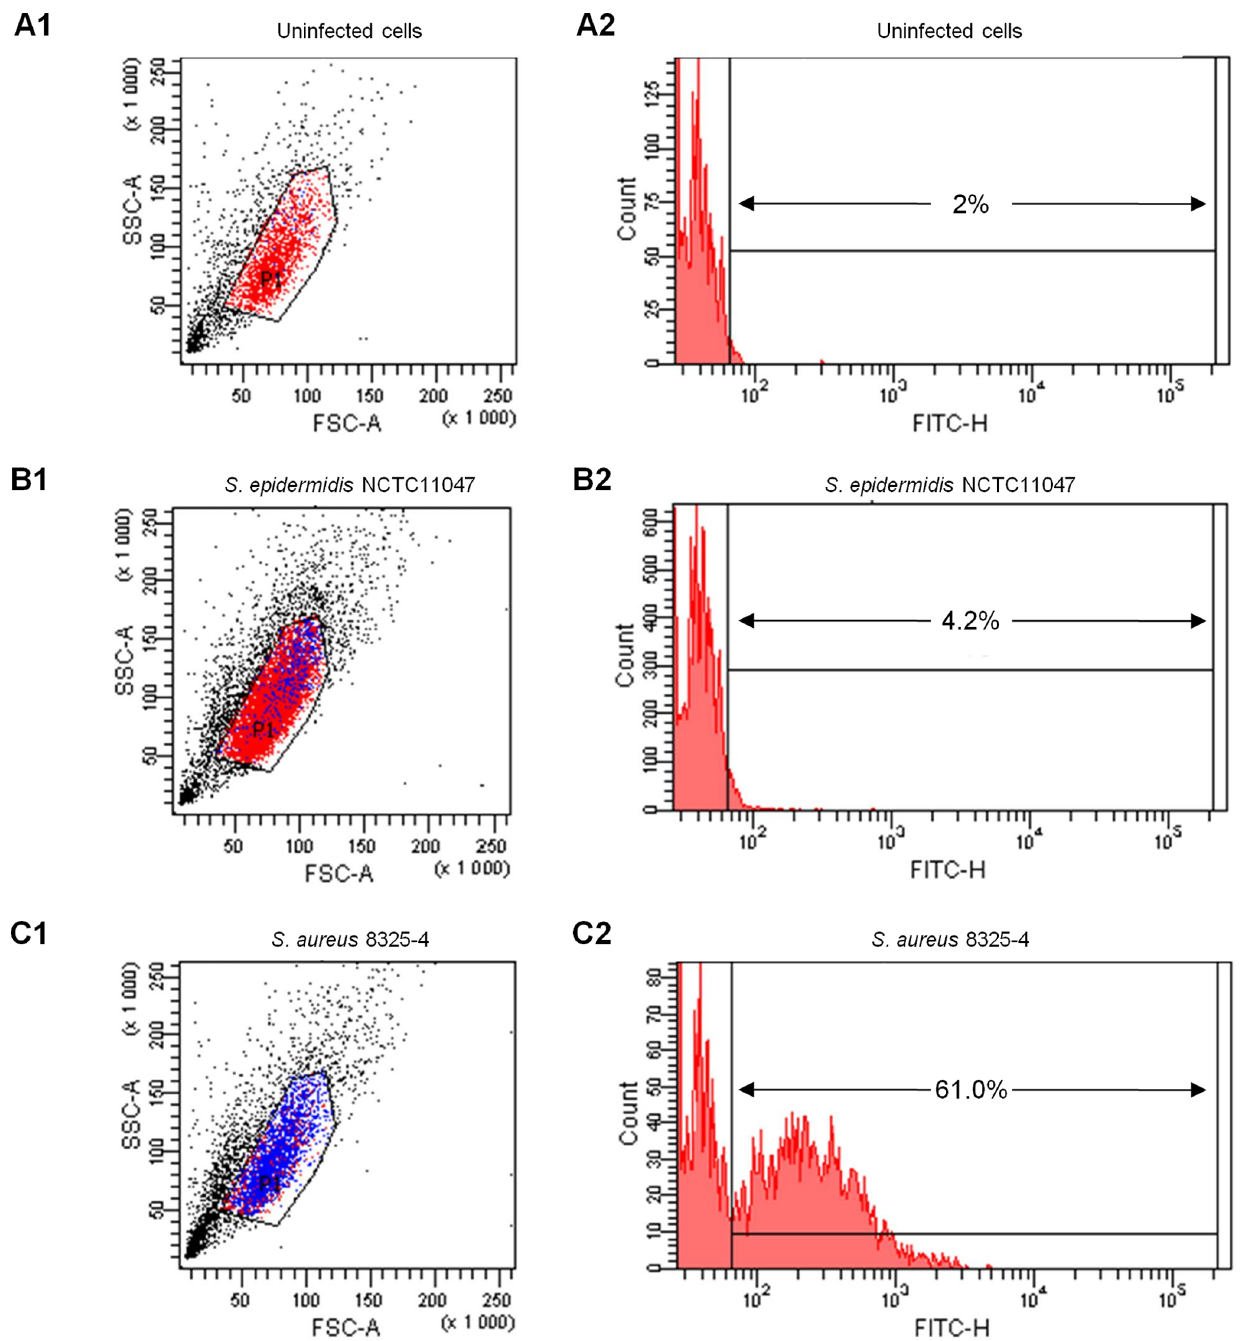
Figure 3. Flow cytometric quantification of adhesion to MG63 osteoblasts by S.epidermidis . Flow cytometry analysis was performed using an FSC/SSC stopping gate with uninfected cells (A1), with a fluorescence intensity marker M set to include , 2% of uninfected cells (A2). The results from the original cytogram (1) and the distribution of FL1-positive events (2) of a representative experiment are shown, including the reference strains S. epidermidis NCTC1147 (B) and S. aureus 8325-4 (C).